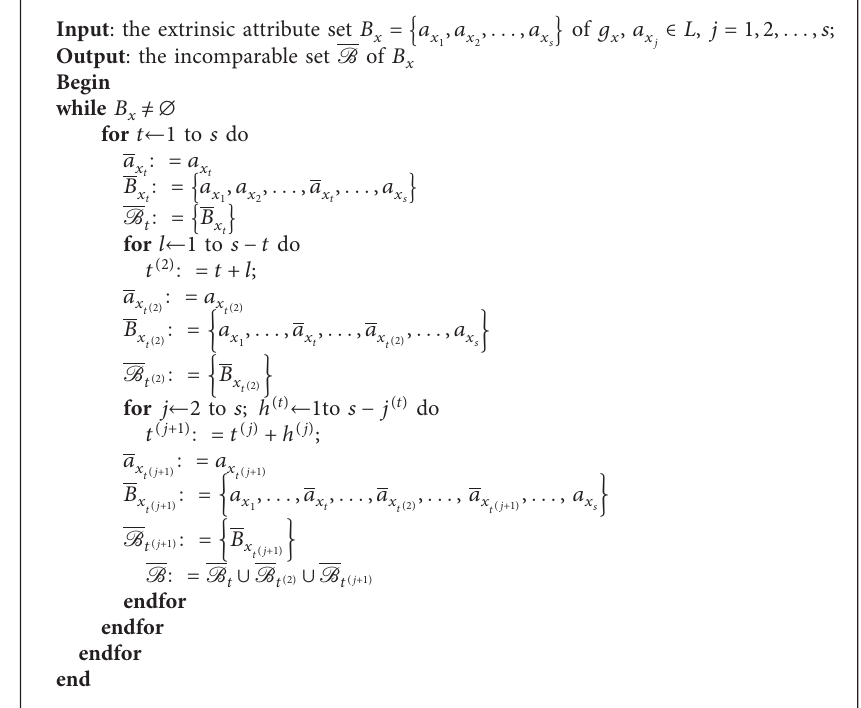
A LGORITHM 3: Incomparable set generation